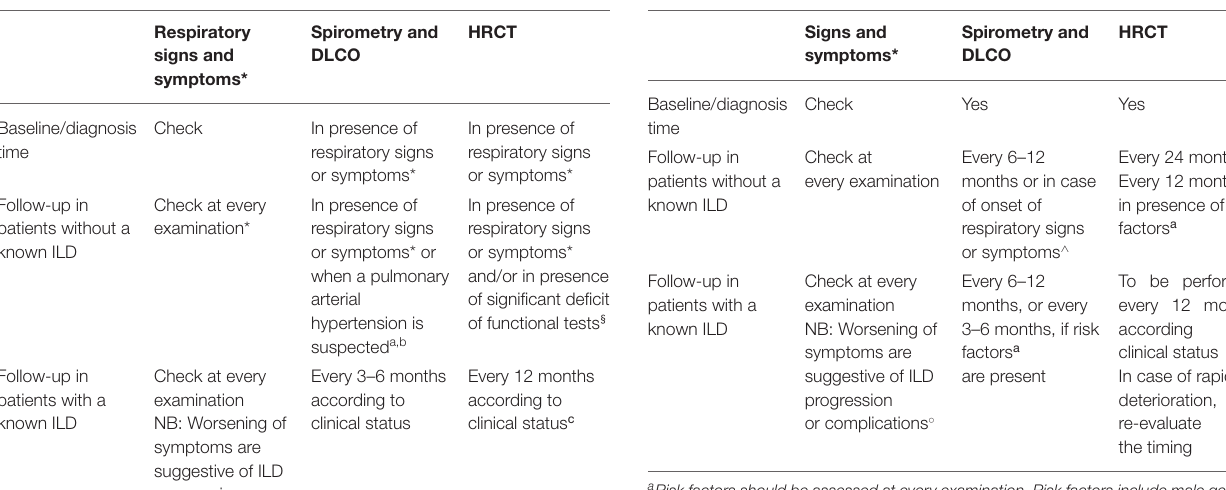
TABLE 5 | Identification and monitoring of RA-ILD. TABLE 6 | Identification and monitoring of